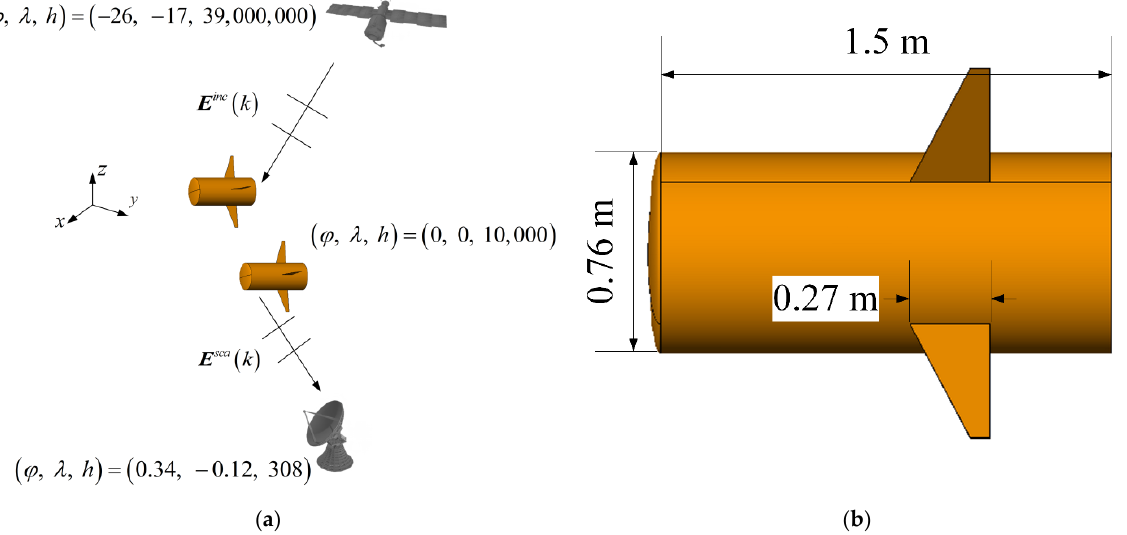
Figure 12. Illustration of the passive bistatic radar system based on non-cooperative satellite-borne illuminator. ( a ) Geometry of the dual missile. ( b ) The model size of the dual missile.